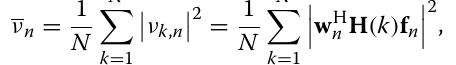
Table 2 An example of the candidate beam database for spatial multiplexing for a 16 channel Beam pair no.